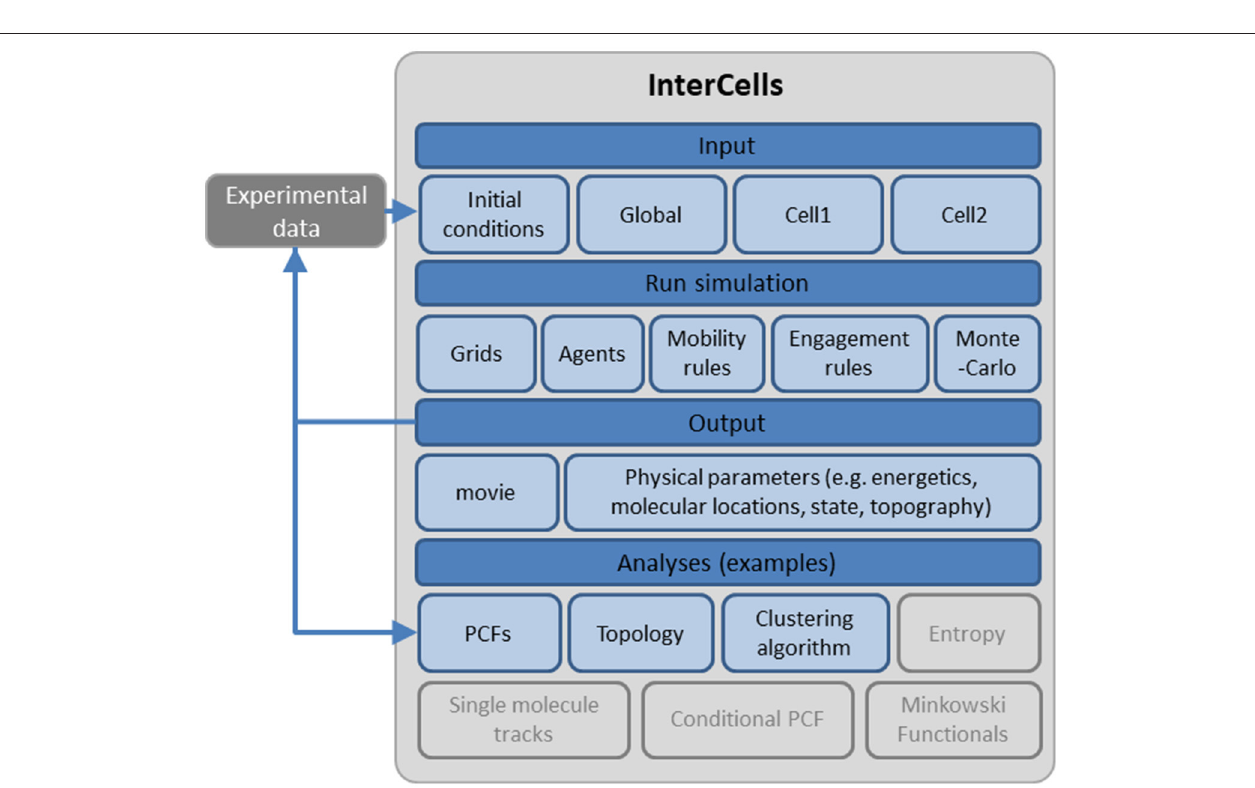
FIGURE 4 | A schematic description of the cell interface simulation. A detailed account of the simulation, its structure and interface are provided as a User’s Guide in the Supplemental Information .